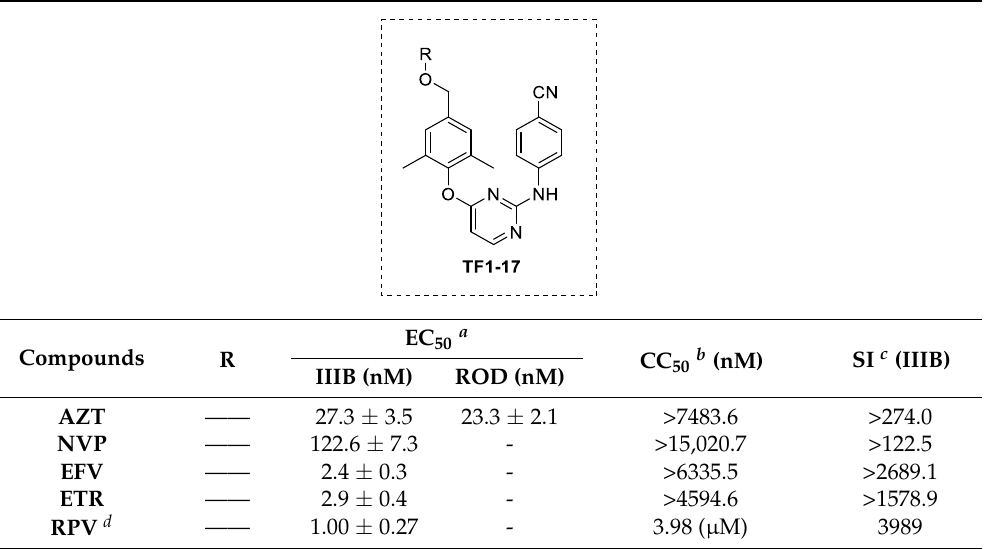
Table 1. The anti-HIV-1(IIIB) activity and cytotoxicity of TF1-17 . Table 1. Cont.